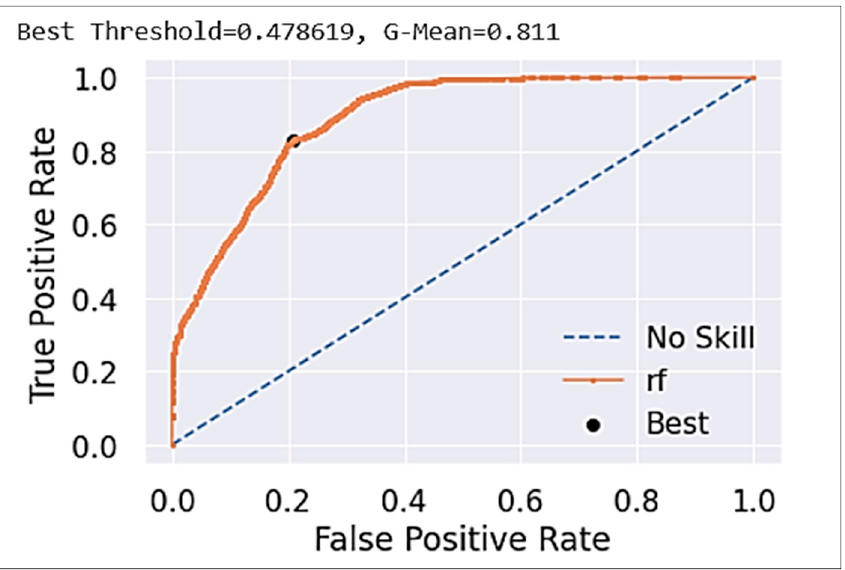
Figure 13. ROC for Combined random forest model.